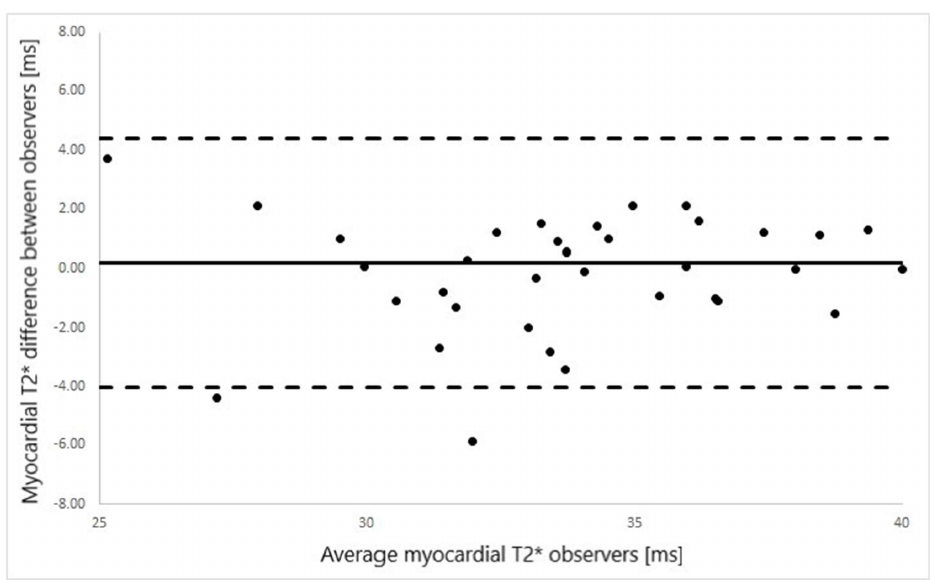
Figure 3. Bland–Altman plot of myocardial T2* values measured by two observers (9 years and 1 year of CMR experience) from the cardiac T2*map.